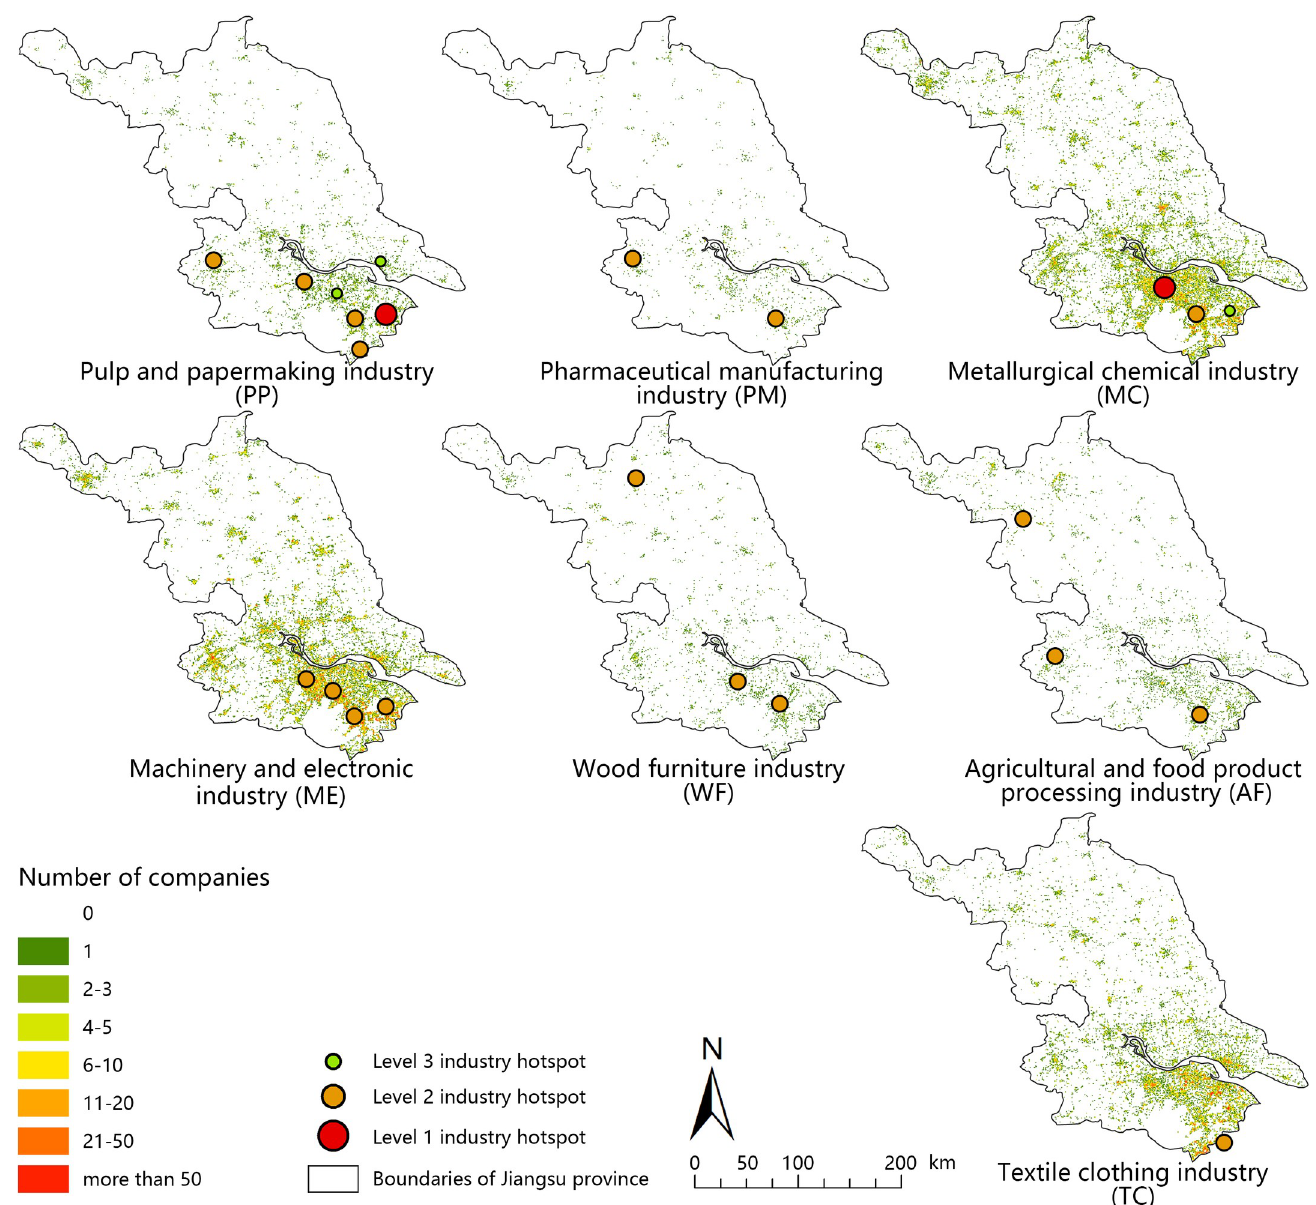
Fig 2. Distribution pattern of various manufacturing industries in Jiangsu province in 2015. Number of different industries in a 1 km × 1 km projection grid in 2015. Hotspots in 2015 were calculated based on manufacturing POIs distribution. The maps were generated by ArcGIS 10.5 and were for illustrative purposes